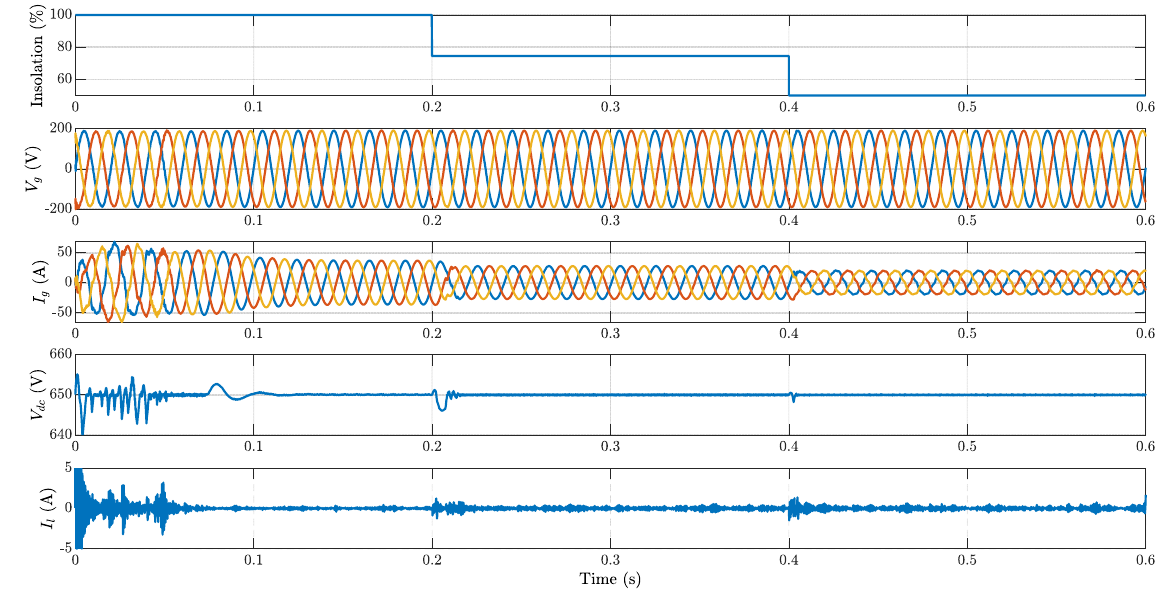
Figure 11. The response of the proposed system to step variations in the isolation level with the HIL simulation, @ weak grid.